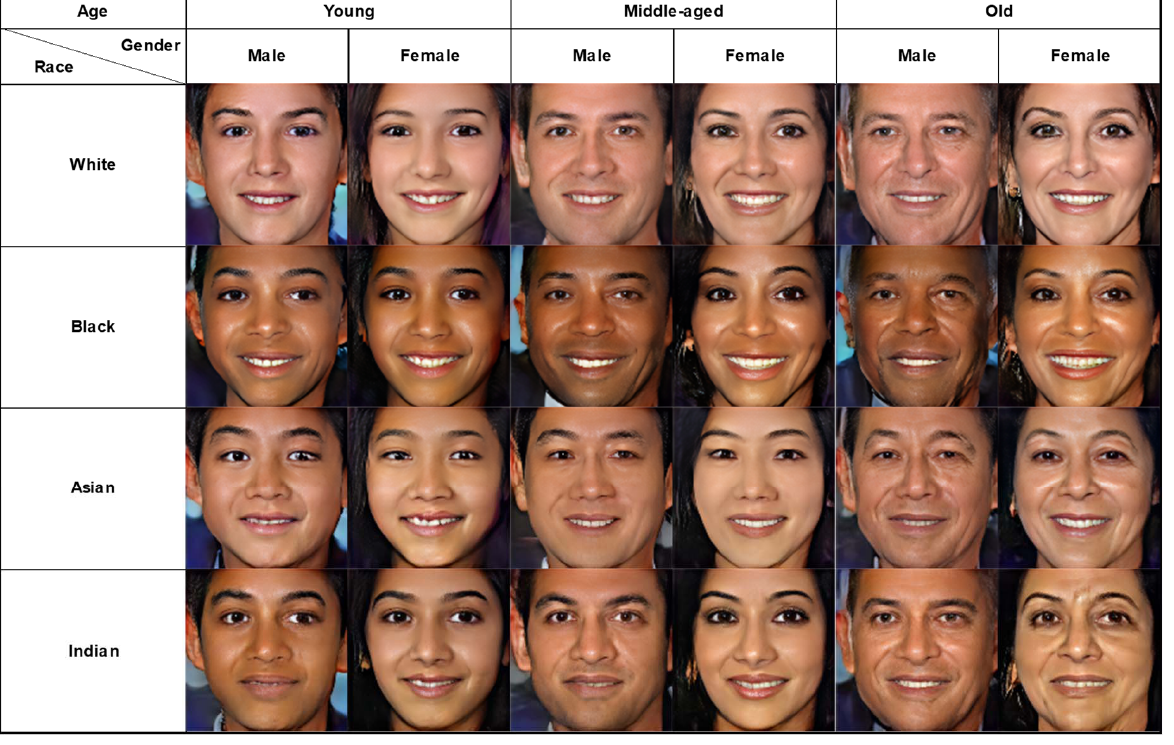
Figure 5. Second set of results of our model: faces from an identical latent vector with 24 different group